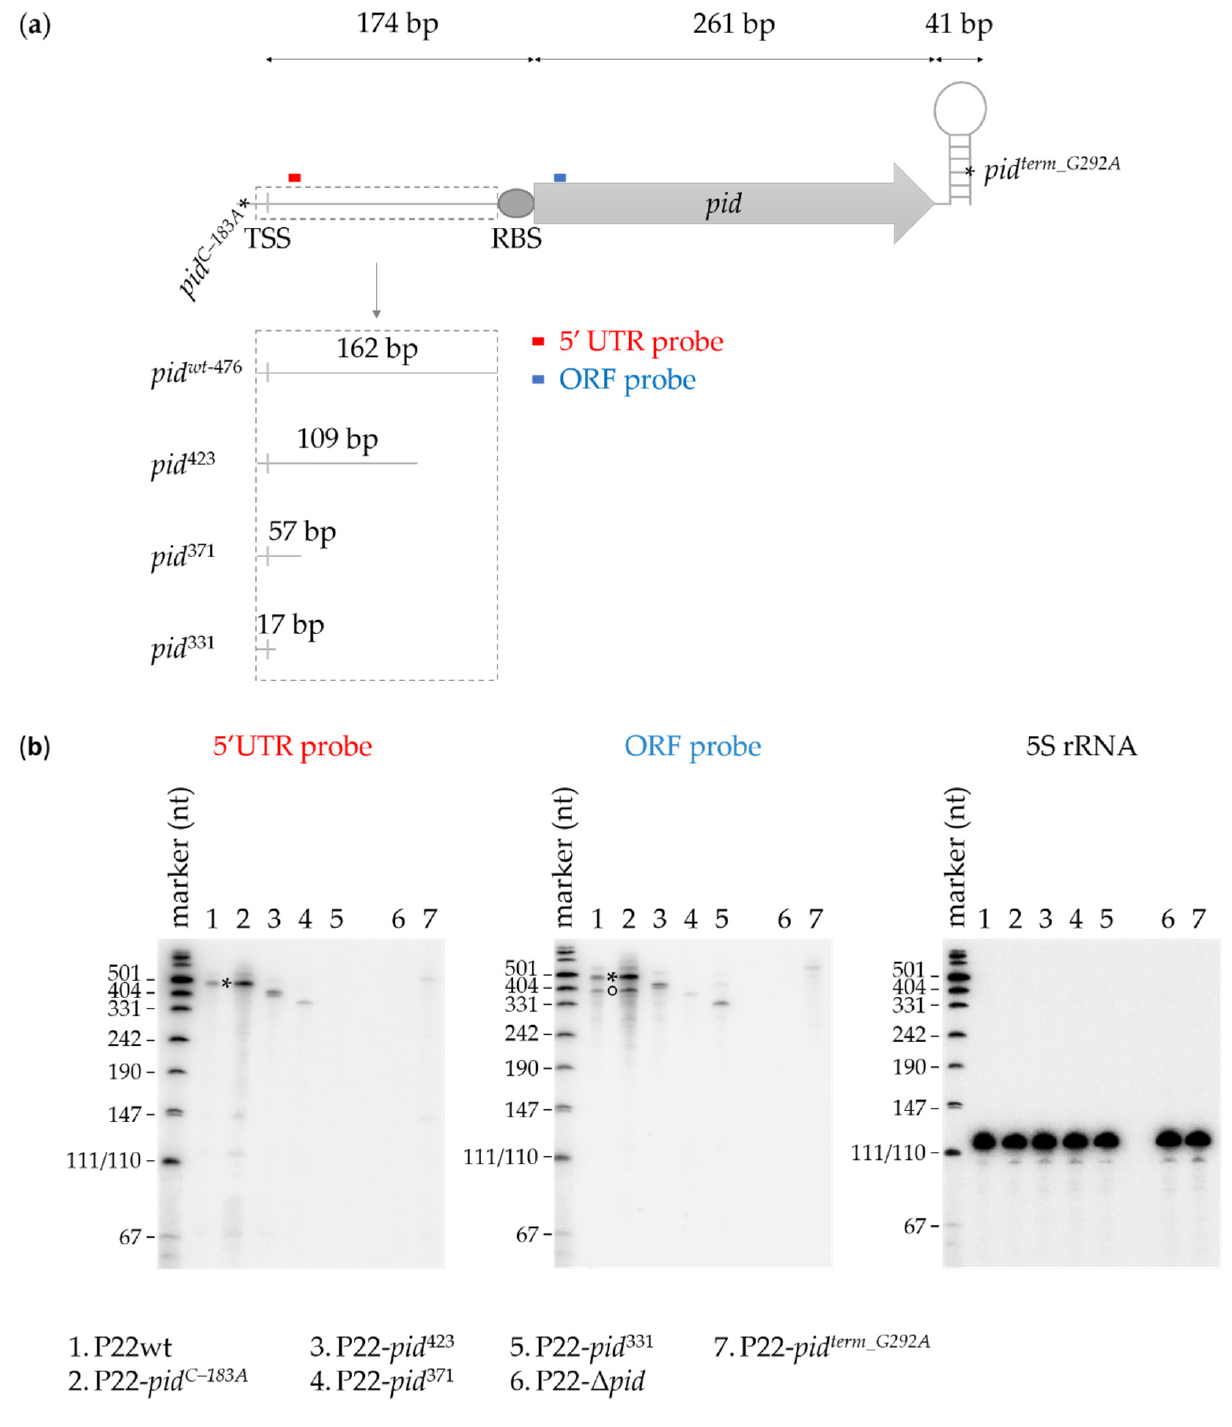
Figure 5. Visualization of the wild-type and mutant pid transcripts. ( a ) Scheme depicting the pid locus of P22wt and its indicated mutants and including the position of the ssDNA Northern blotting probes targeting either the 5 (cid:48) UTR region or the ORF region of the transcript. ( b ) Representative images of the Northern blots of the pid transcript expressed by P22wt and the indicated P22 mutants during high MOI infection of LT2. Northern blots were labelled with either the 5 (cid:48) UTR (left panel) or ORF (middle panel) probe, and infection with P22- ∆ pid was included as a negative control. The 5S rRNA loading controls are shown in the right panel. The F- and S-bands of lanes 1–2 are marked by * and ◦ , respectively.